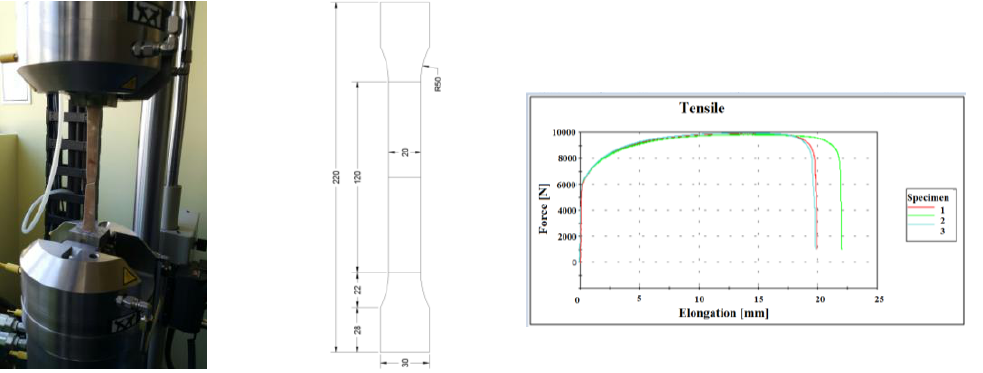
Fig.12 Steel specimen Fig.13 Force-elongation diagram-steel